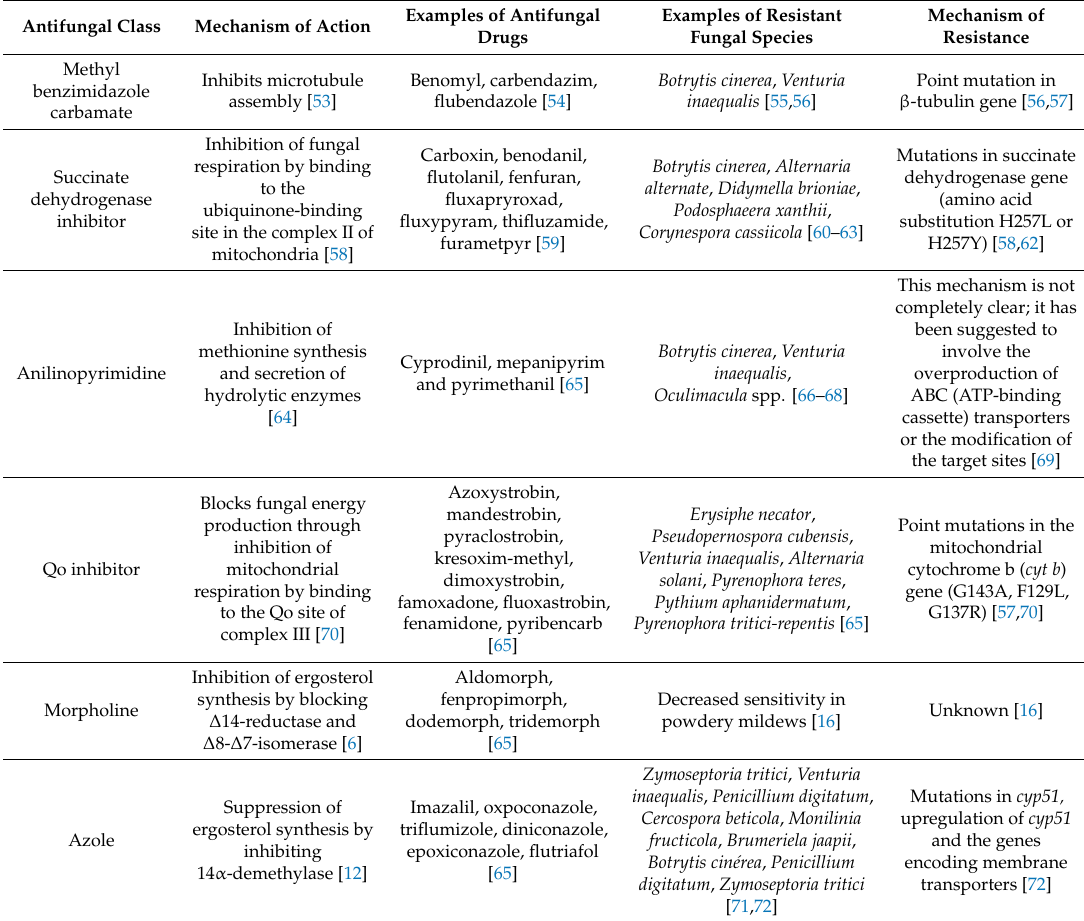
Table 2. The main classes of antifungal drugs and the mechanisms of development of resistance to